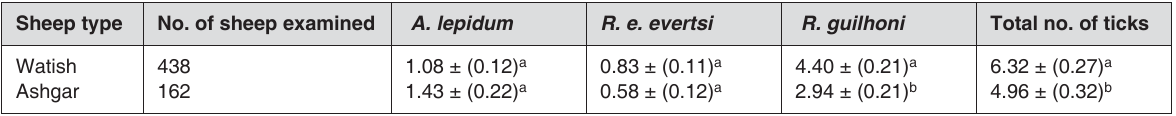
TABLE 3 Mean (± SE) numbers ticks collected from different sheep types Sheep type